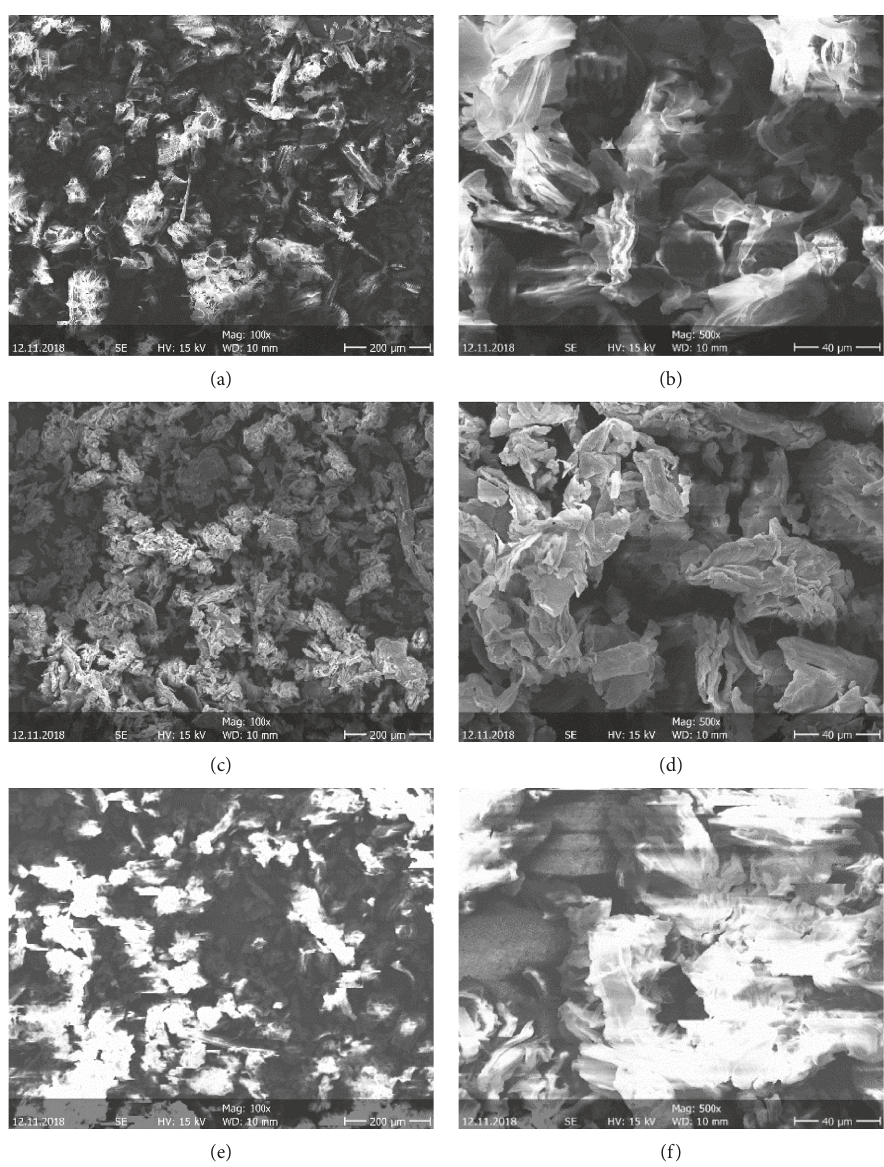
Figure 3: SEM images of (a, b) raw POF, (c, d) NaOH-treated POF, and (e, f) CTAB-modified